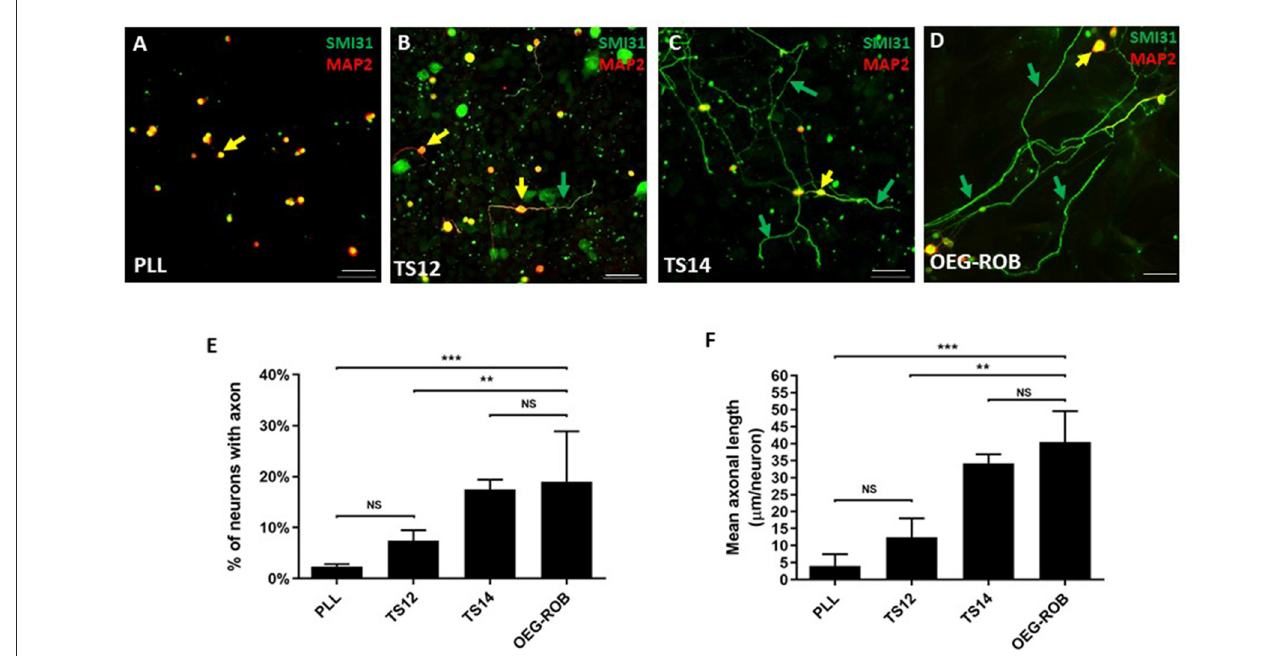
FIGURE2 Analysis of the regenerative capacity of OEG-ROB in an in vitro model of adult axonal regeneration. (A–D) show representative images of axotomized retinal ganglion neurons after 96h in co-culture with OEG. OEG human cell line TS14 was used as a positive control for neuroregeneration (C) and human cell line TS12 (B) and PLL (A) correspond to low regeneration and negative controls, respectively; (D) corresponds to OEG-ROB. Green arrows indicate axons positive for axonal marker SMI31 (green) and yellow arrows indicate somas and dendrites positive for somatodendritic marker MAP2 (red) (antibody 514 against MAP2A&B). Histograms represent the mean ± SD of the quantifications: percentage of retinal neurons extending an axon (E) and the mean axon size expressed as µ m/neuron (F) . Statistical tests applied were one-way ANOVA and post-hoc Tukey test (*** p ≤ 0.001; ** p ≤ 0.01; NS, not significant) for multiple comparisons between means ( n = 4, per experiment ≥ 30 fields were analyzed). Scale bar: 50 µ m.